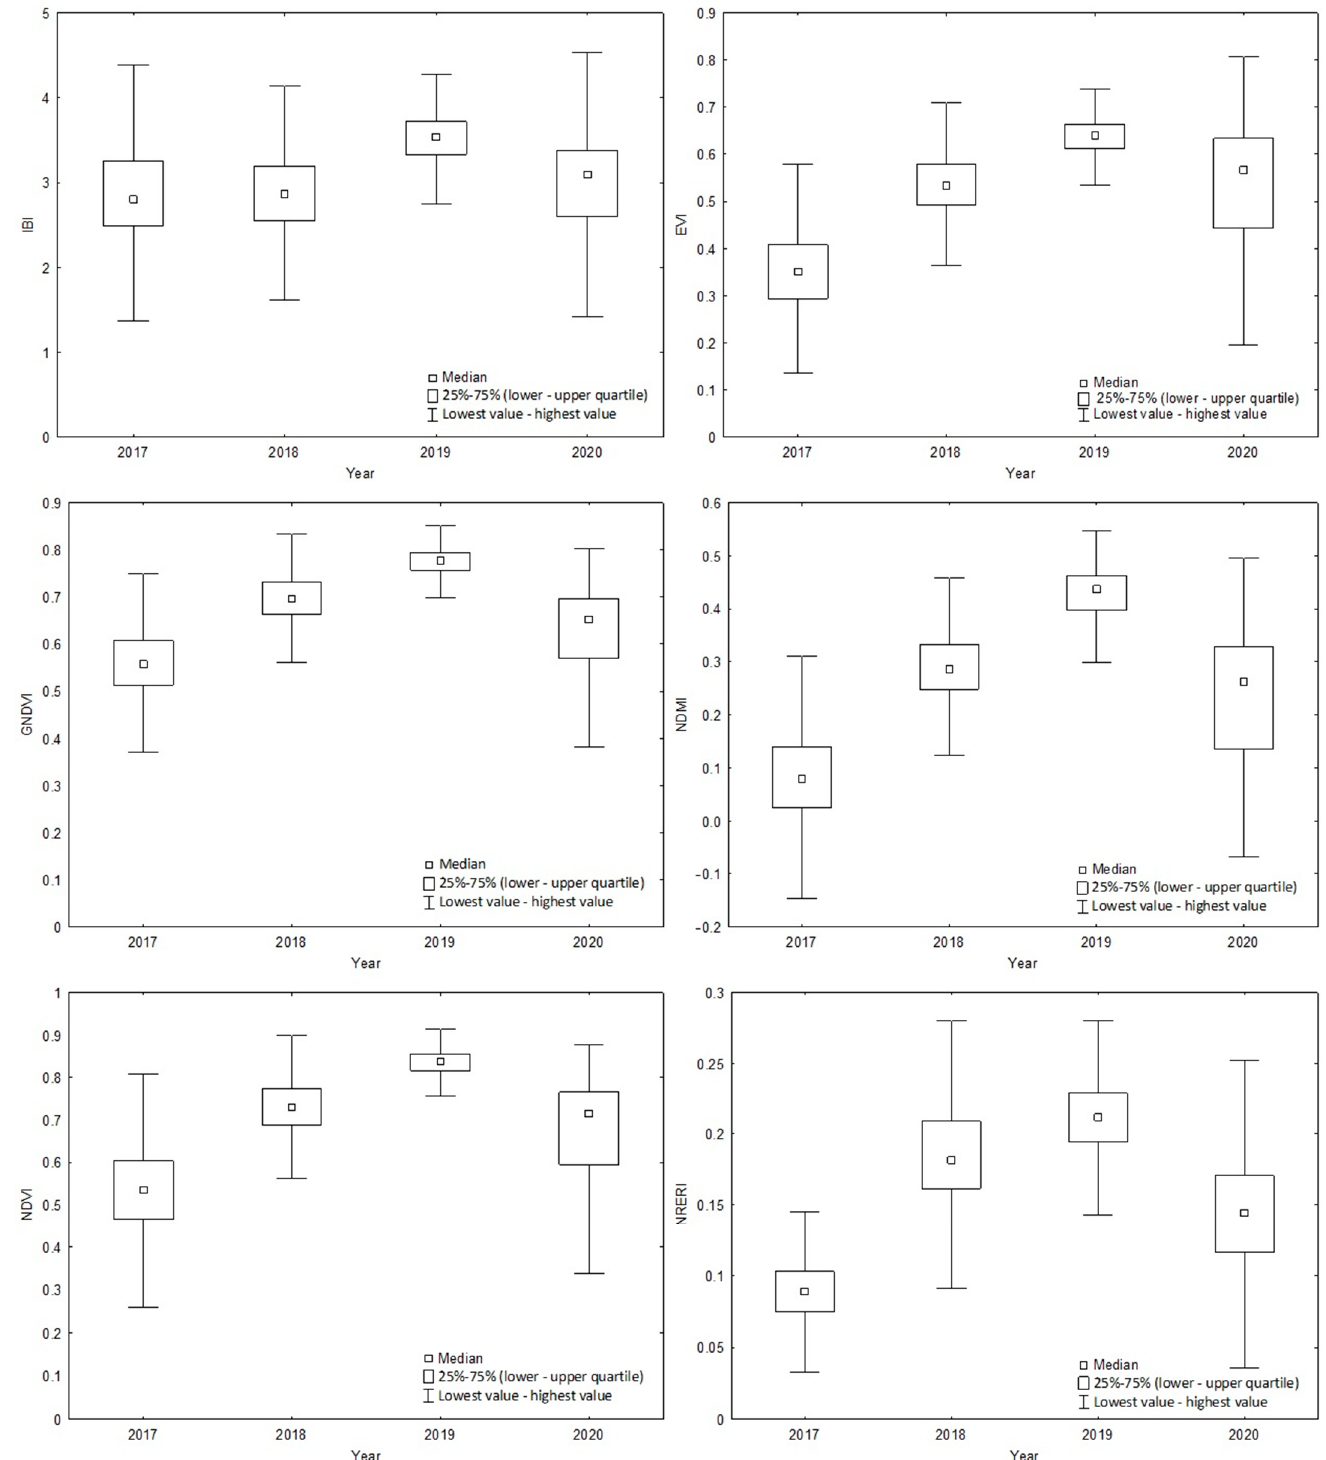
Figure A1. Vegetation indices for the individual years (2017, 2018, 2019, 2020): Boxes show Quarter 1 (25%) and Quarter 3 (75%), red squares show the median and black brackets show minimal and maximal values.